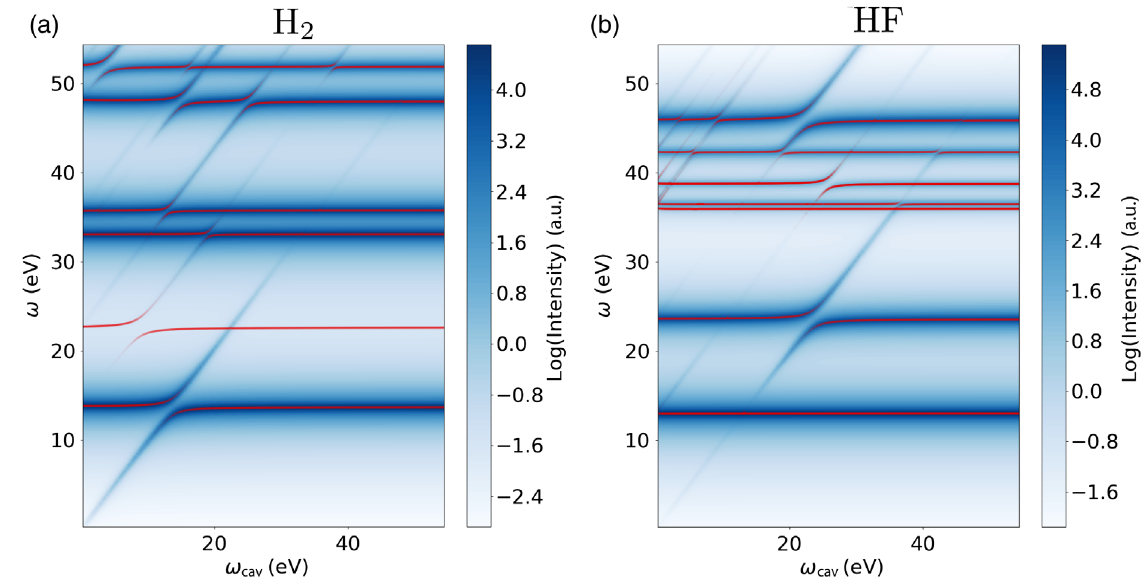
FIG. 9. Comparison between QED-CCSD-1 (red solid lines) and QED-FCI (contour map in the background) energy dispersion plots for (a) H 2 and (b) HF. The intensity of the red lines indicates the electronic or photonic contribution to the states, λ ¼ 0 . 05 and η ¼ 0 . 01 a : u :